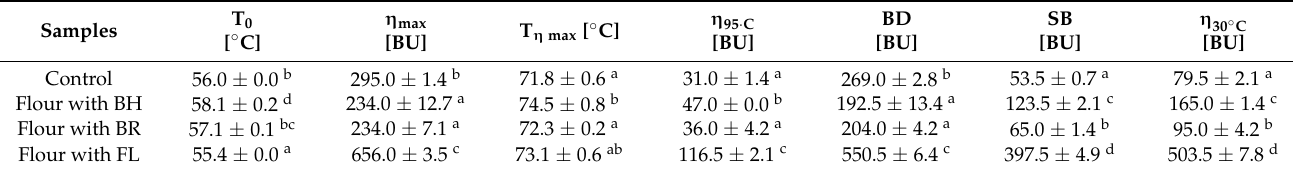
Table 3. Pasting characteristics of flour